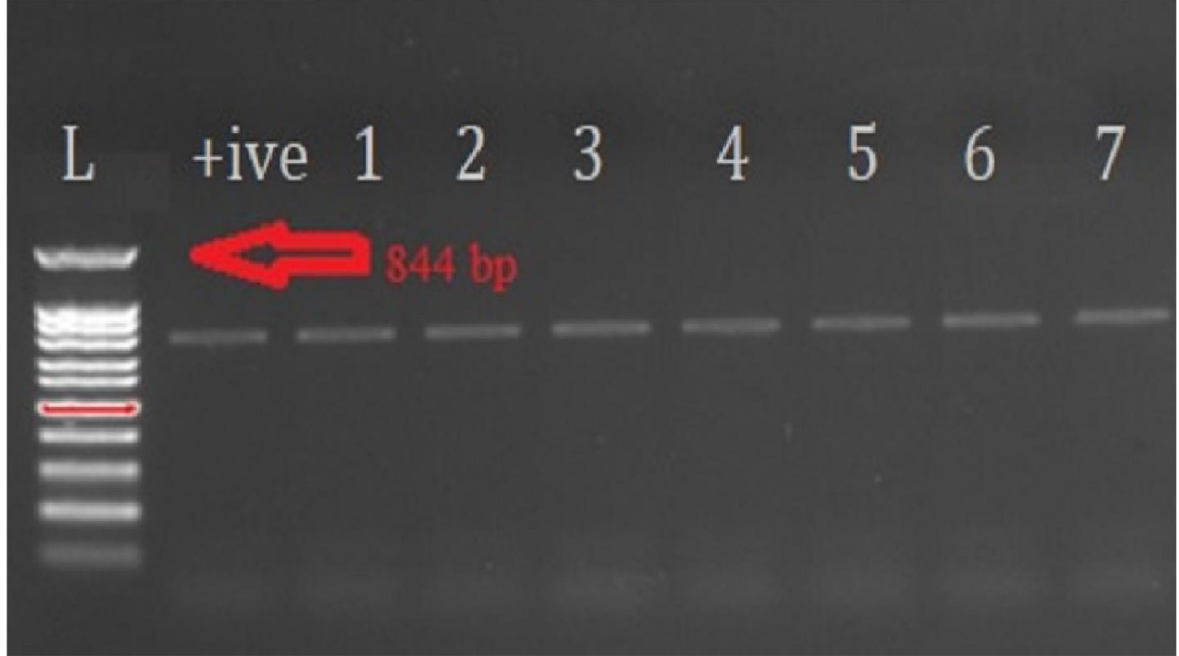
Fig 3. Products of PCR for the detection of USP (884bp) gene on 1.5% EB-stained agarose gel amplified from E . coli isolates from broilers, where L 100 bp DNA ladder; +ve is positive control ( E . coli ATCC 25922); lane 1–7: E . coli isolates.